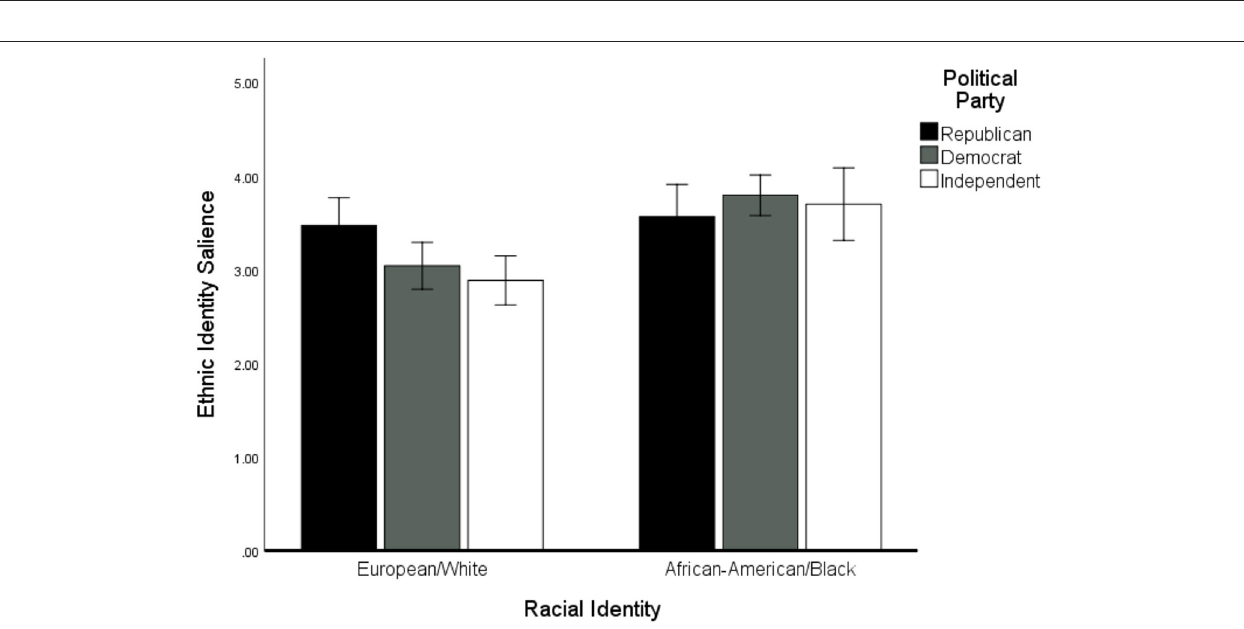
FIGURE 2 | Relationship between political party affiliation and pro-Trump attitudes by racial identity. Note. Error bars represent 95% CIs around the mean for each subgroup.